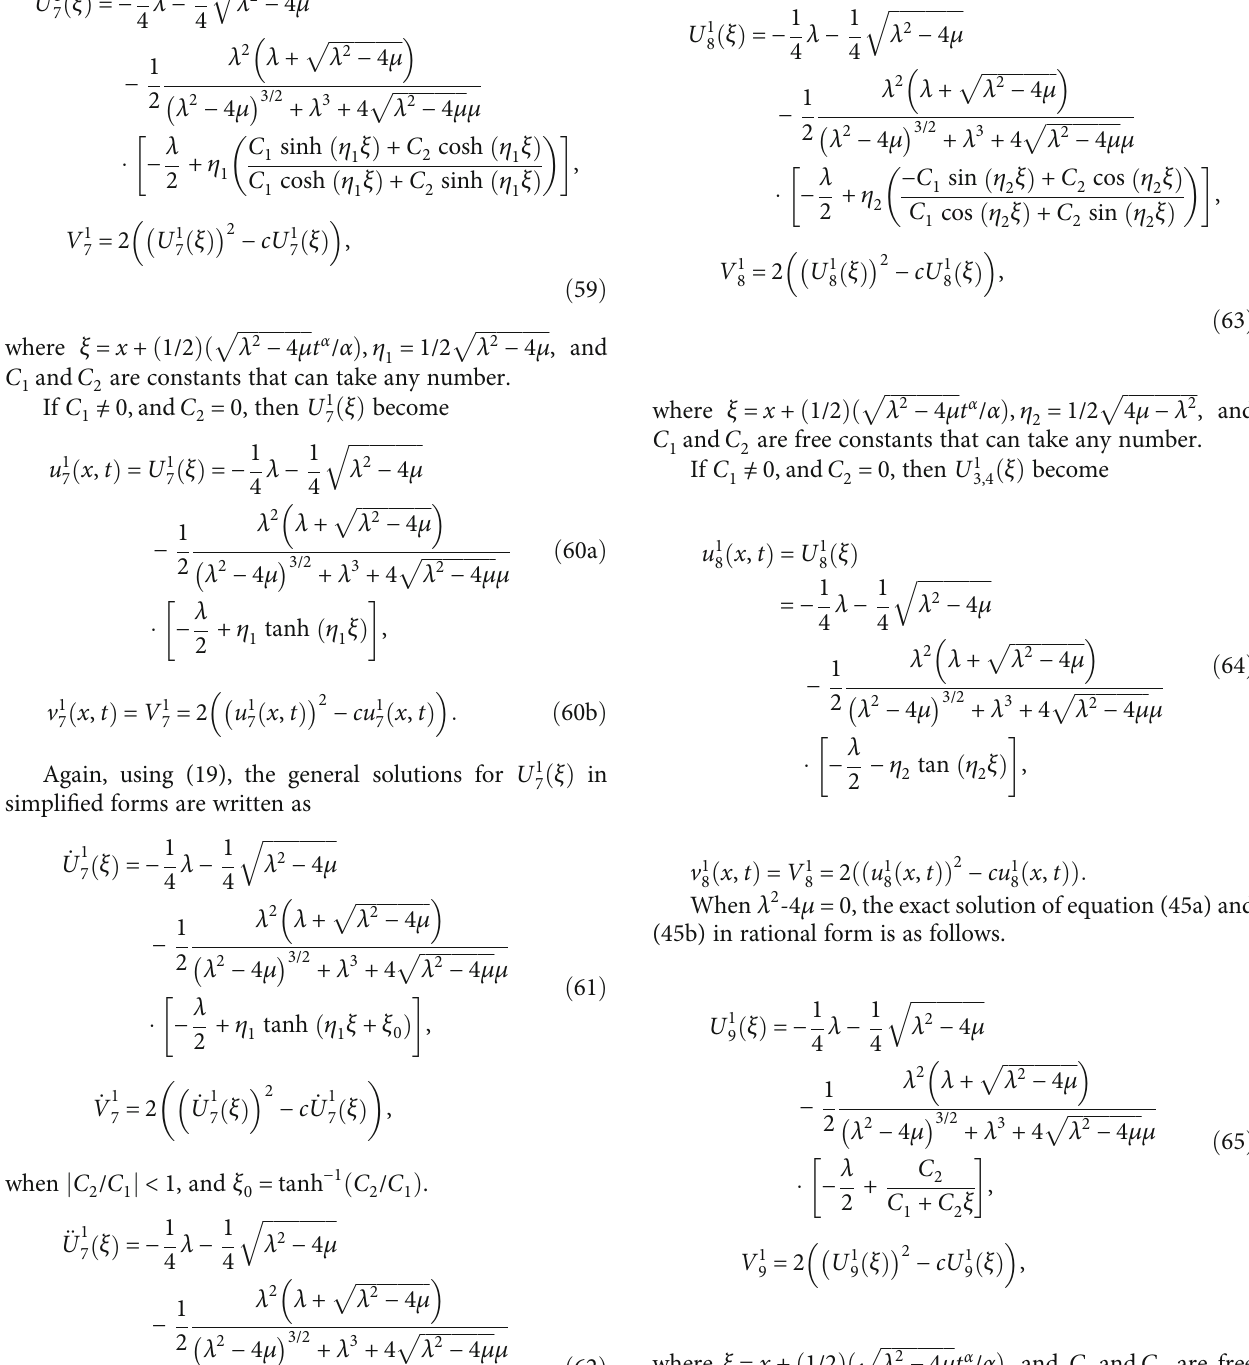
ffiffiffiffiffiffiffiffiffiffiffiffiffiffiffi p(cid:4)